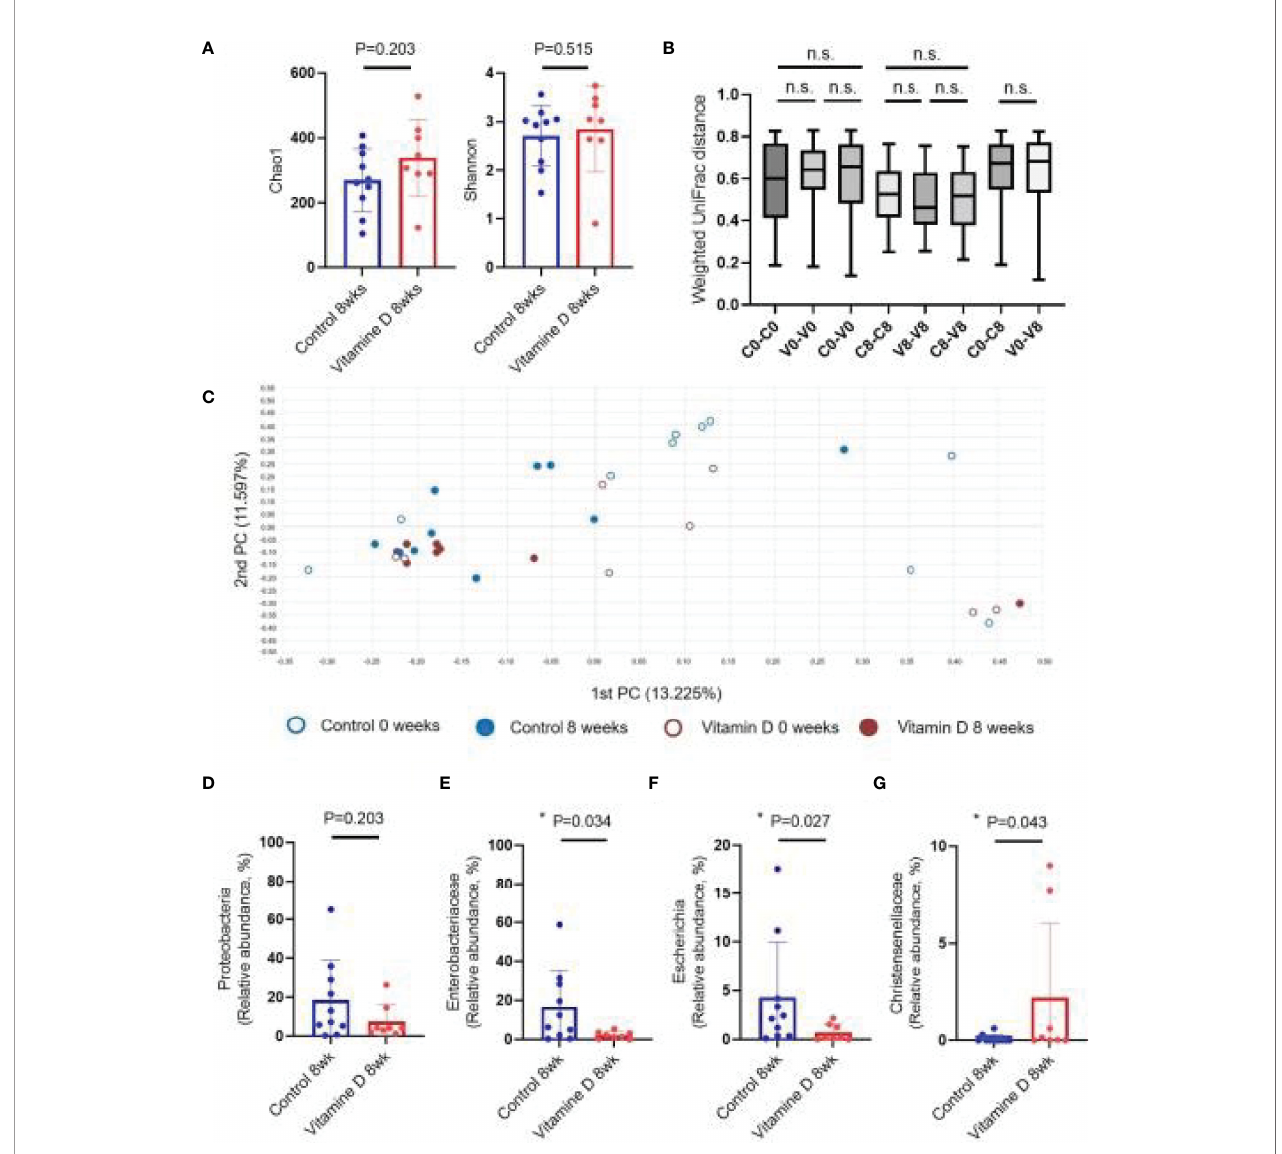
FIGURE 3 | Effect of vitamin D supplementation on the gut microbiome. (A) Alpha diversity. (B) Weighted UniFrac distance. (C) Principal coordinates analysis (Bray – Curtis dissimilarity). (D) Relative abundances of Proteobacteria . (E) Relative abundances of Enterobacteriaceae . (F) Relative abundances of Escherichia. (G) Relative abundances of Christensenellaceae . n.s, not signi fi cant; *P < 0.05 (Wilcoxon signed rank test and Mann-Whitney U